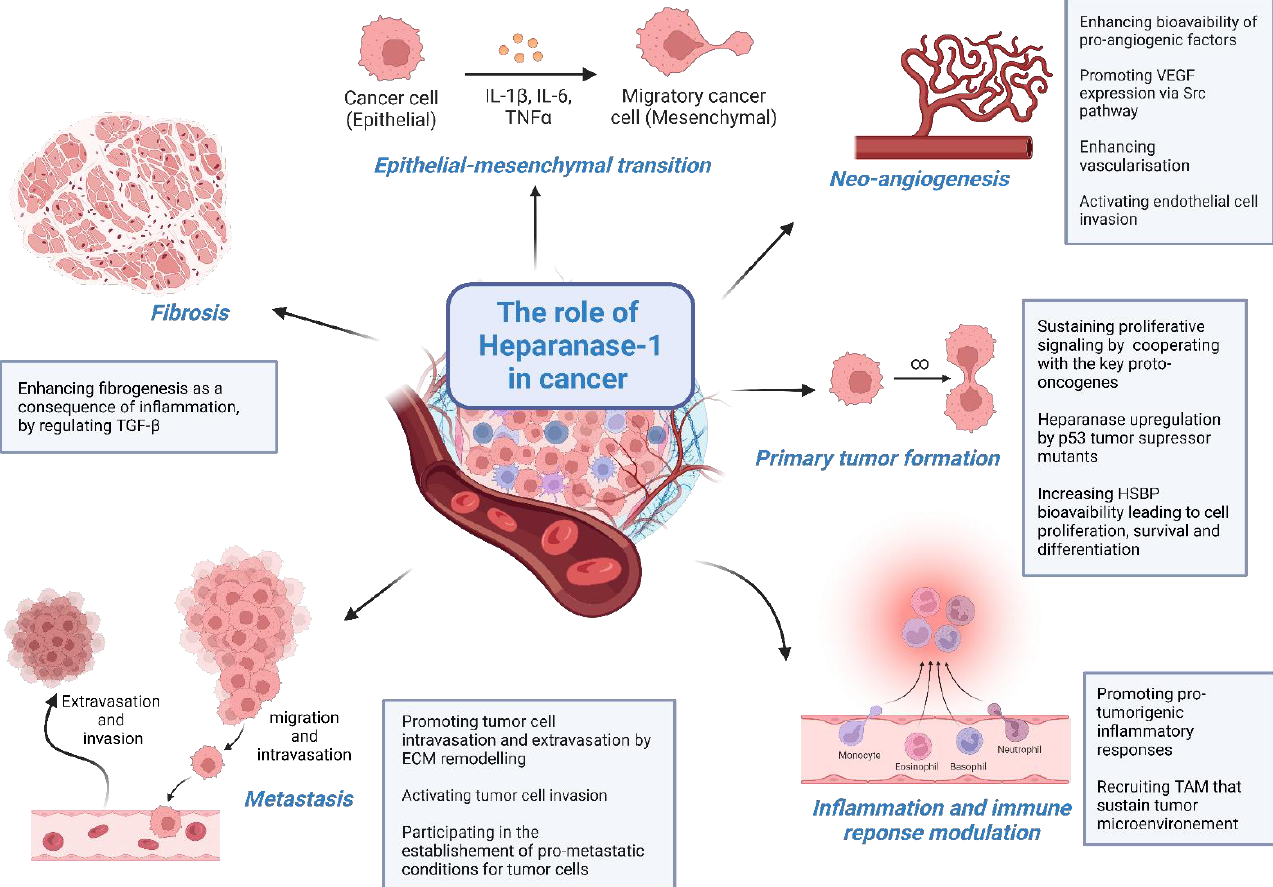
Figure 1. Major contributions of heparanase-1 in cancer. The enzymatic and non-enzymatic activities of heparanase-1 are involved in carcinogenesis, from the very early steps of tumor initiation to late stages including metastasis and invasion. Heparanase-1 plays a major role in several processes e.g., ECM remodeling, HS turnover, cell migration, tissue vascularization and remodeling, inflammation, and proliferation. As a global consequence, heparanase-1 contributes significantly to the establishment of the tumor microenvironment. Abbreviations: ECM (extracellular matrix), HSBP (heparan sulphate binding proteins), TAM (tumor-associated macrophages). [Created with BioRender.com].